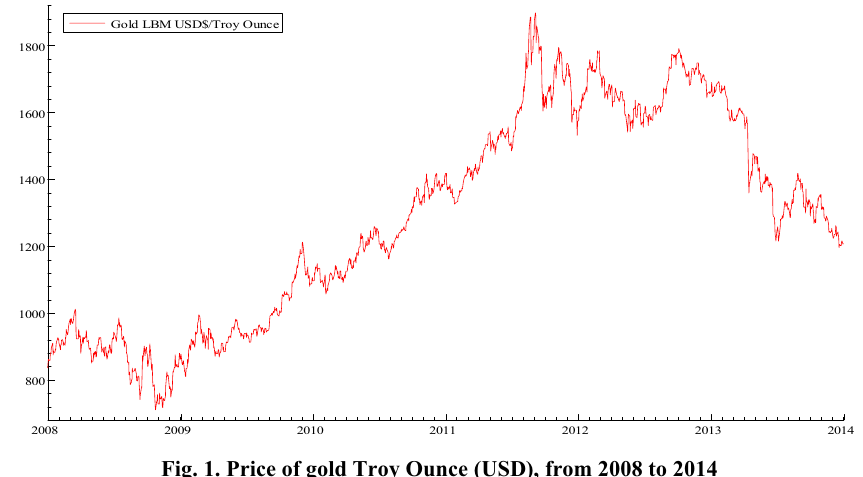
Fig. 1. Price of gold Troy Ounce (USD), from 2008 to 2014 Table 1. Descriptive statistics for returns of gold and Z assets for the sample